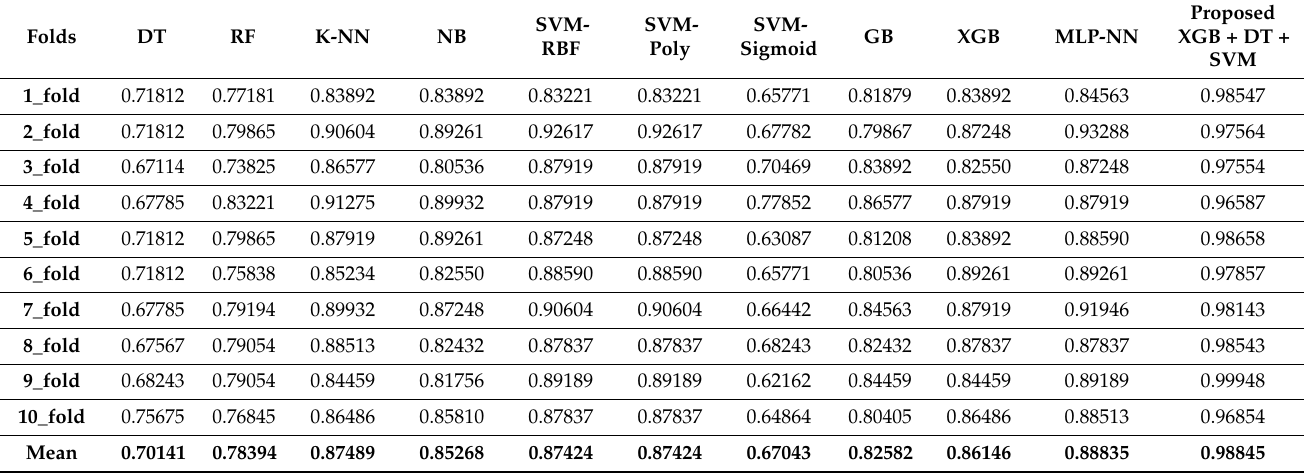
Table 7. Ten-fold cross-validation after parameter optimization (hyperparameter tuning).